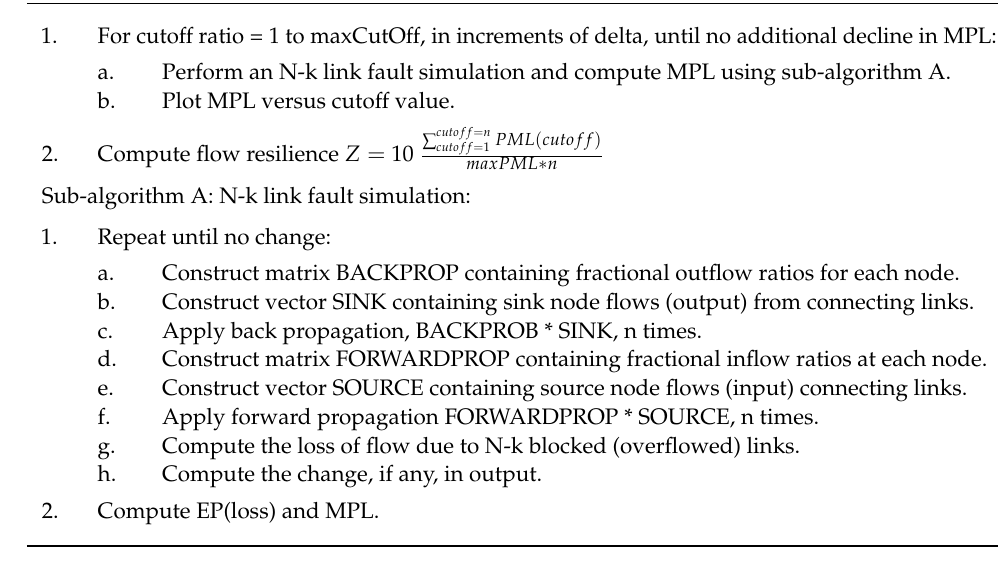
Algorithm 1 : N-k Z Resilience